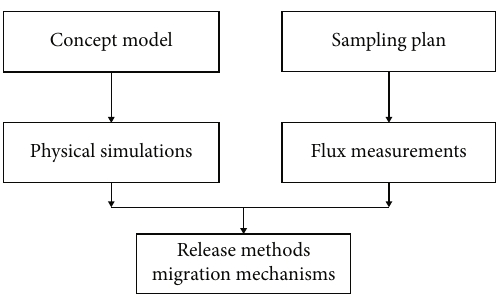
Figure 1: The steps of the